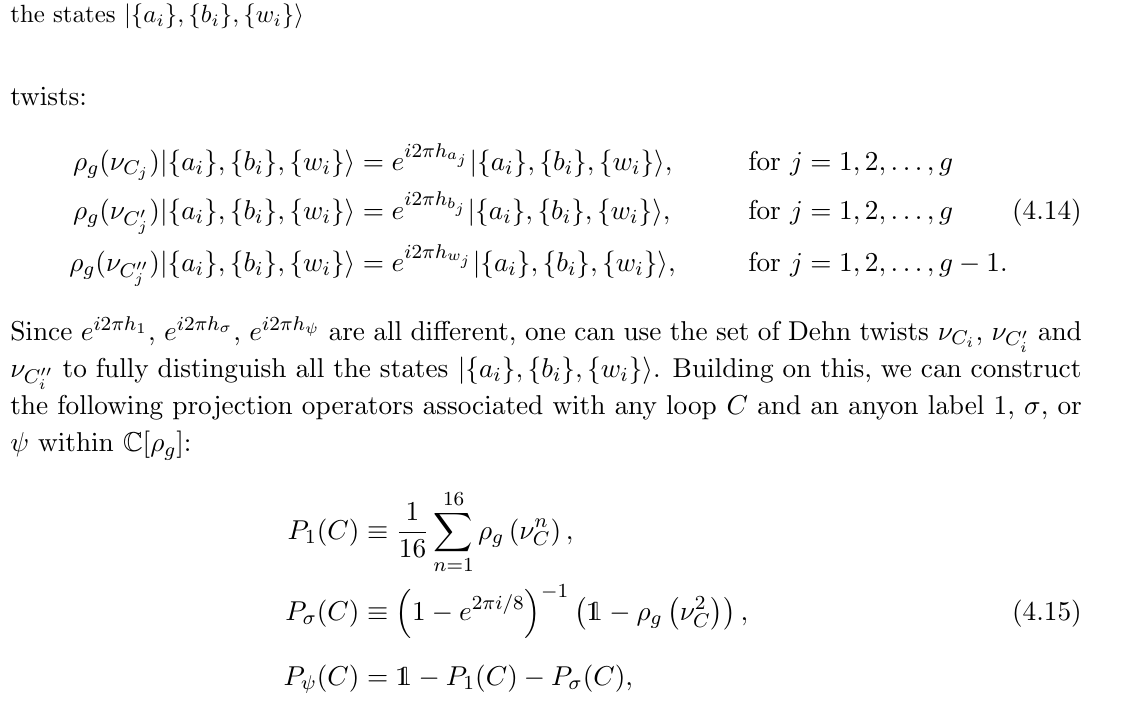
and C 00 can distinguish all of 1 ; 2 ;:::;g 1 ; 2 ;:::;g (cid:0) 1